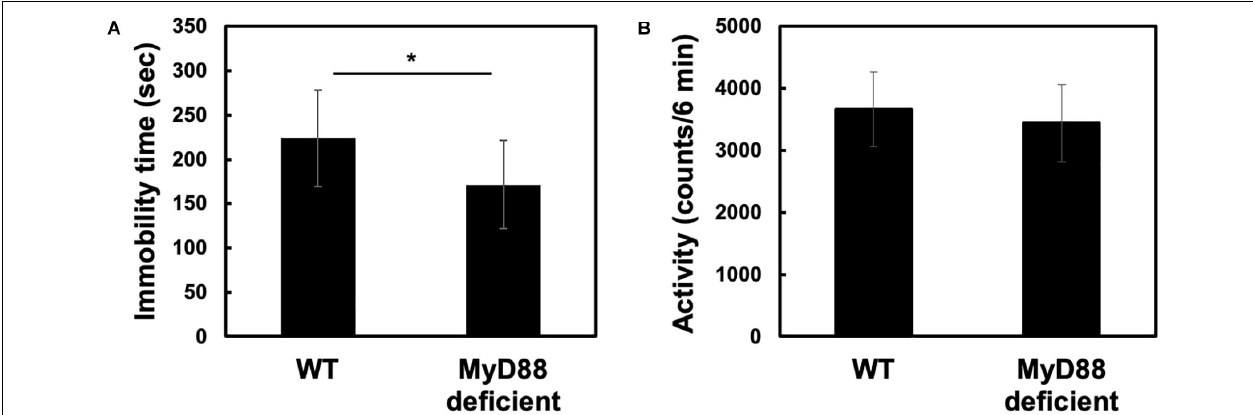
FIGURE 1 | MyD88 deficiency decreased immobility time without affecting locomotor activity in the forced swim test. (A) Wild-type (WT) and MyD88-deficient (MyD88 deficient) mice were forced to swim for 6 min, and the immobility time was calculated. Values are presented as means ± SD. Student’s t -test: * p < 0.05; (WT: n = 12; MyD88 deficient: n = 12). (B) MyD88 deficiency did not affect locomotor activity. Locomotor activities (6 min) were measured for each genotype (WT and MyD88 deficient mice). Values are presented as means ± SD; Student’s t -test: not significance; (WT: n = 10; MyD88 deficient: n = 9).